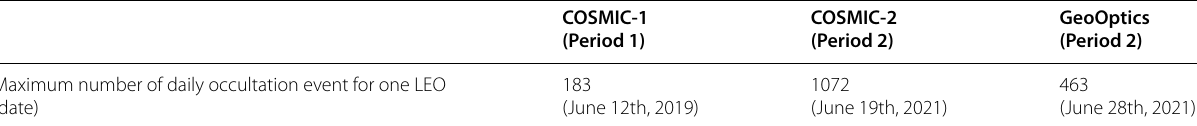
Table 3 Maximum number of daily occultation events from one LEO for each RO system